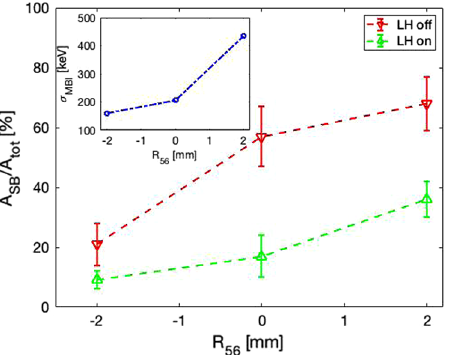
FIG. 5. Measured average spectral area of sidebands with the laser heater turned off (red triangles) and on (green triangles), the latter being the value which maximizes the FEL brilliance. In the inset, predicted σ calculated for the laser heater MBI